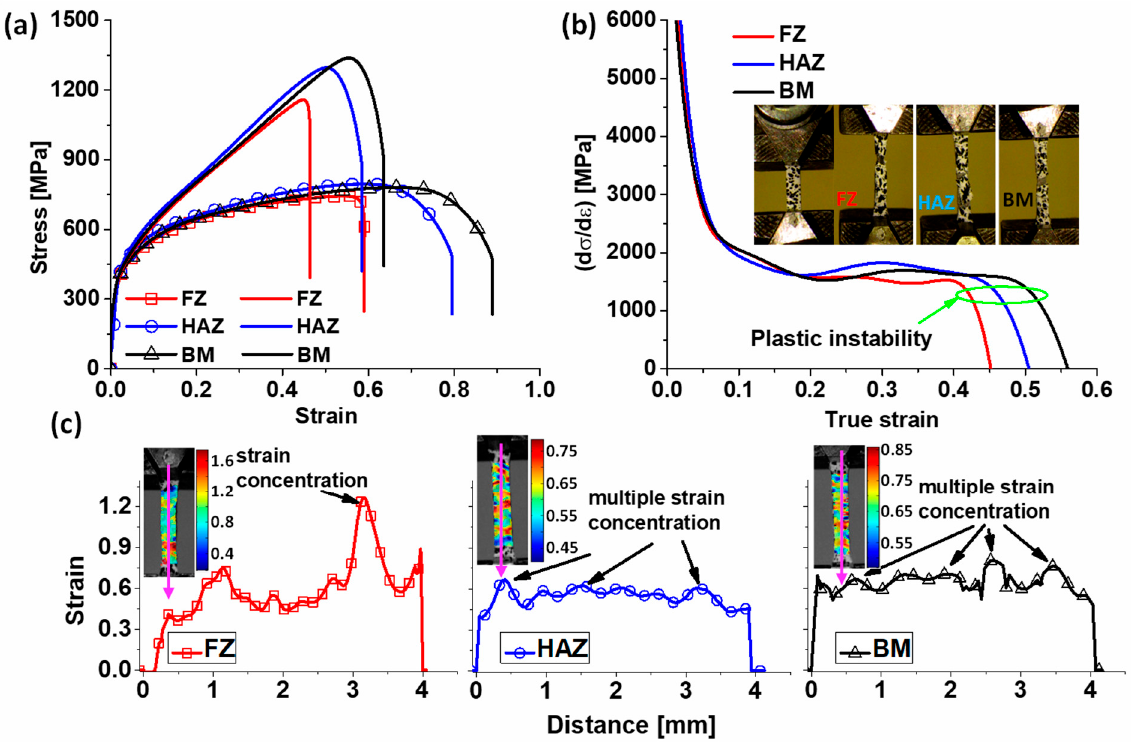
Figure 9. ( a ) True and engineering tensile curves, ( b ) strain hardening rate curves, and ( c ) strain maps and profiles for the different analyzed zones before the plastic instability starts (the strain profiles were obtained along the vertical direction following the pink color arrow, so distance on X axis means the length of the analyzed zone being 0 in the upper part, i.e., the beginning of the arrow).